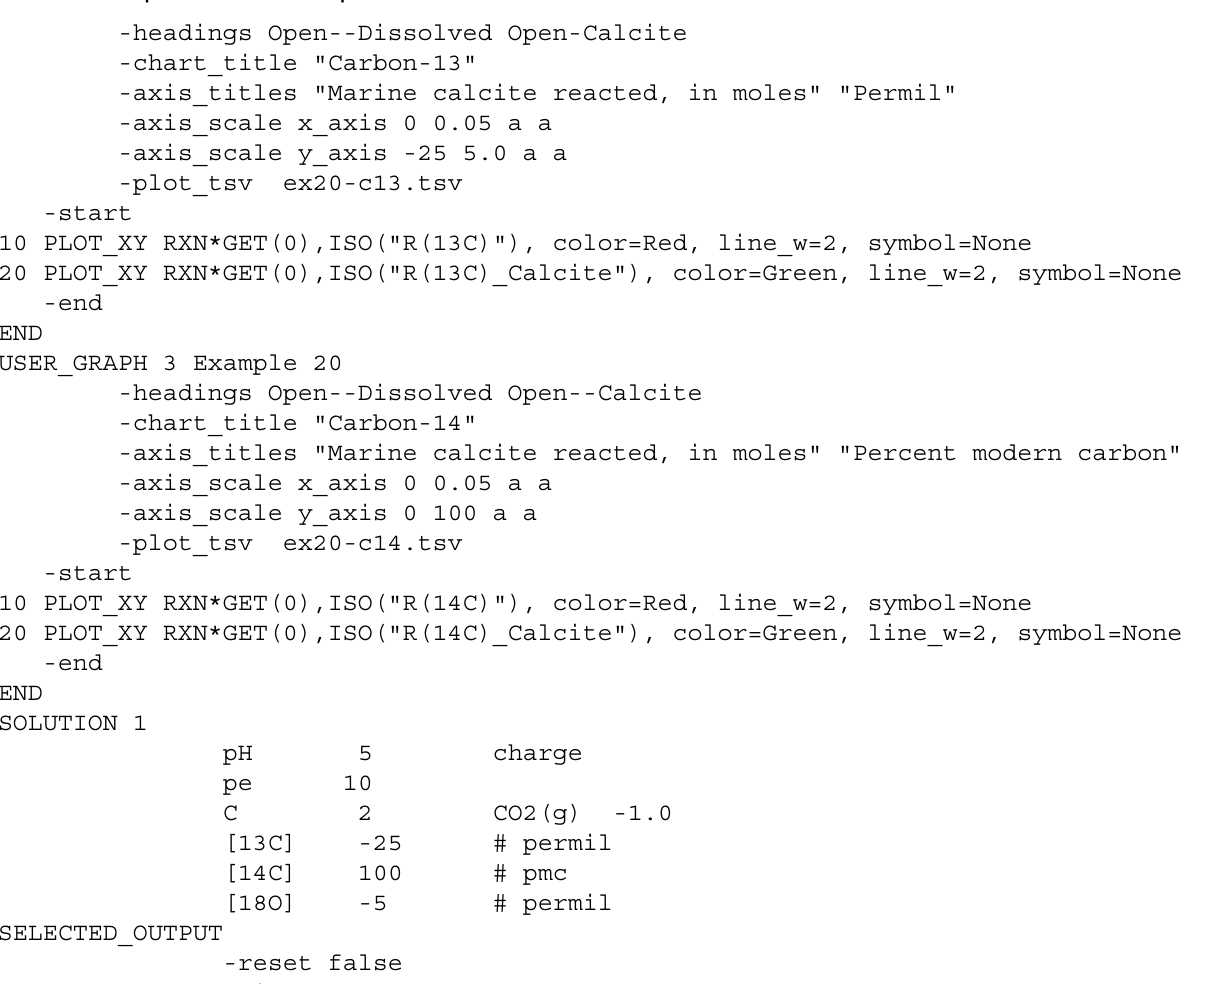
Table 59. Input file for example 20B.—Continued -headings Open--Dissolved Open-Calcite